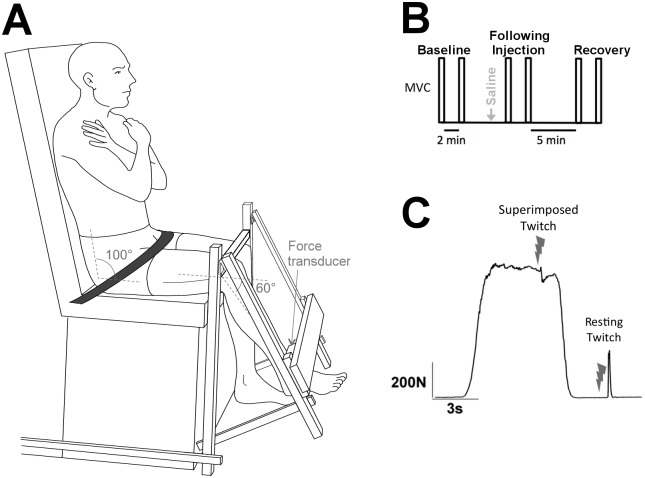
Experimental setup and protocol.A: Knee extension force was assessed with a three-dimensional sensor. Straps were placed on the hip, thighs and ankle (not shown) to limit body movements. B: Experimental protocol for each injection type. Participants performed two maximal voluntary contractions (MVC) at each time condition (baseline, following injection (< 3 min), recovery). C: Supramaximal electric stimulation was delivered to the quadriceps muscle during maximal voluntary contraction (MVC) and at rest.